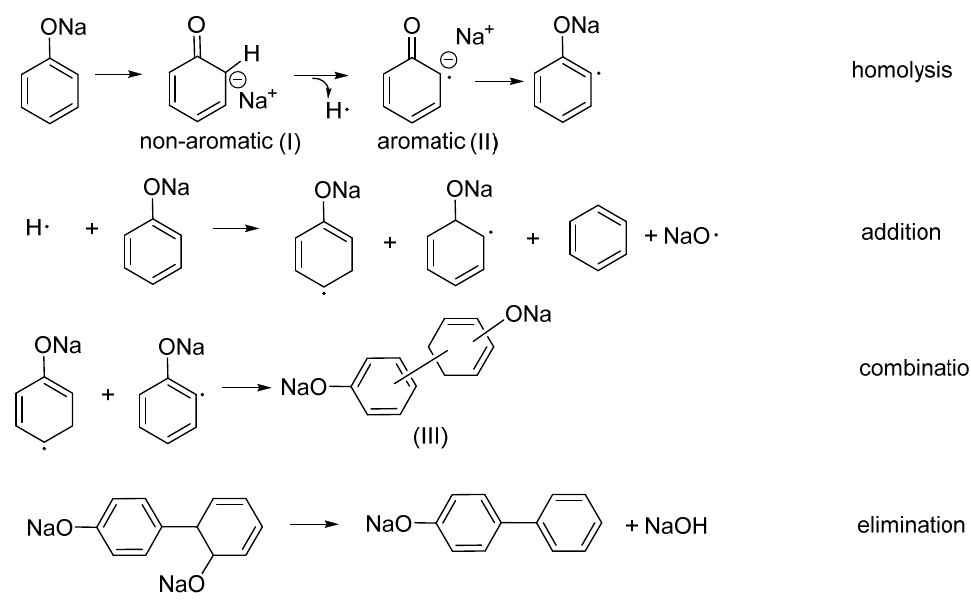
Scheme 2. Hydroarylation and elimination of sodium phenolate.